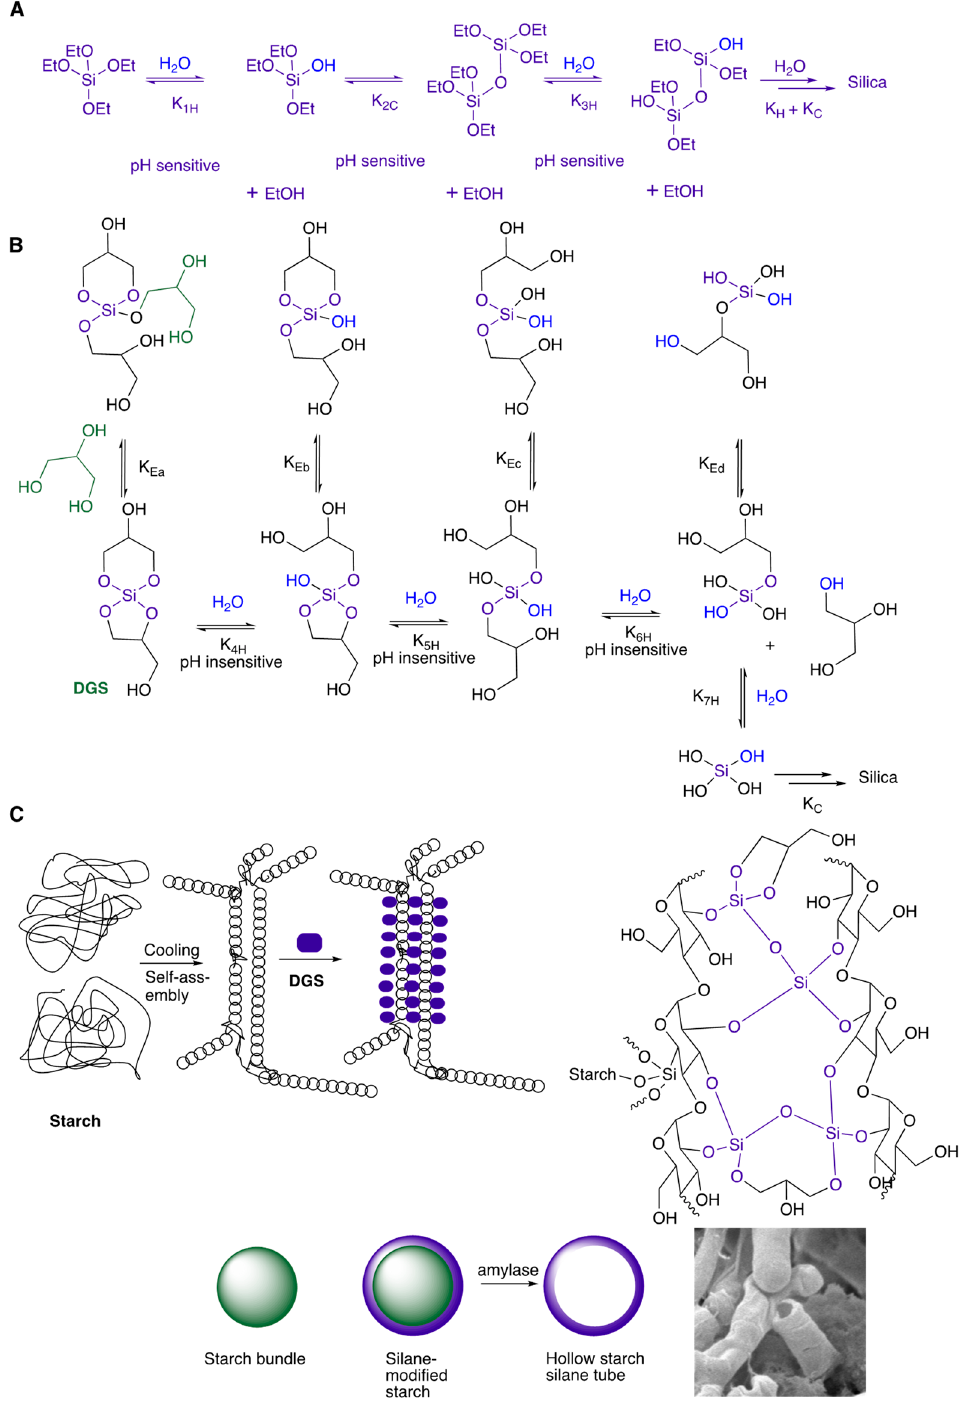
Figure 7. Model reactions leading to silica/starch composites from ( A ) TEOS, ( B ) DGS and ( C ) transesterification with starch (adapted from ref. [20] ).